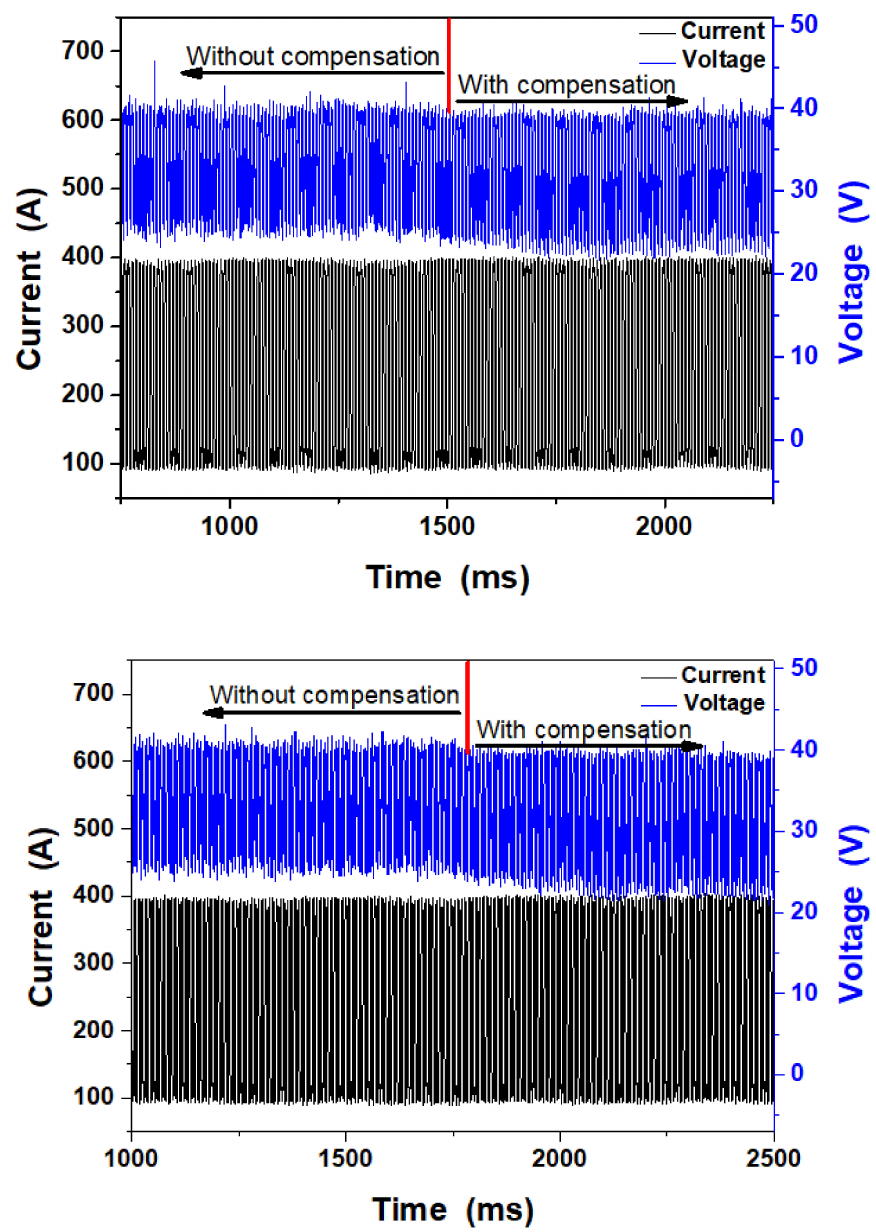
Figure 4. Current and voltage waveforms during the butt welding of 304 stainless steel: ( a ) Sample 1#; ( b ) sample 2#.